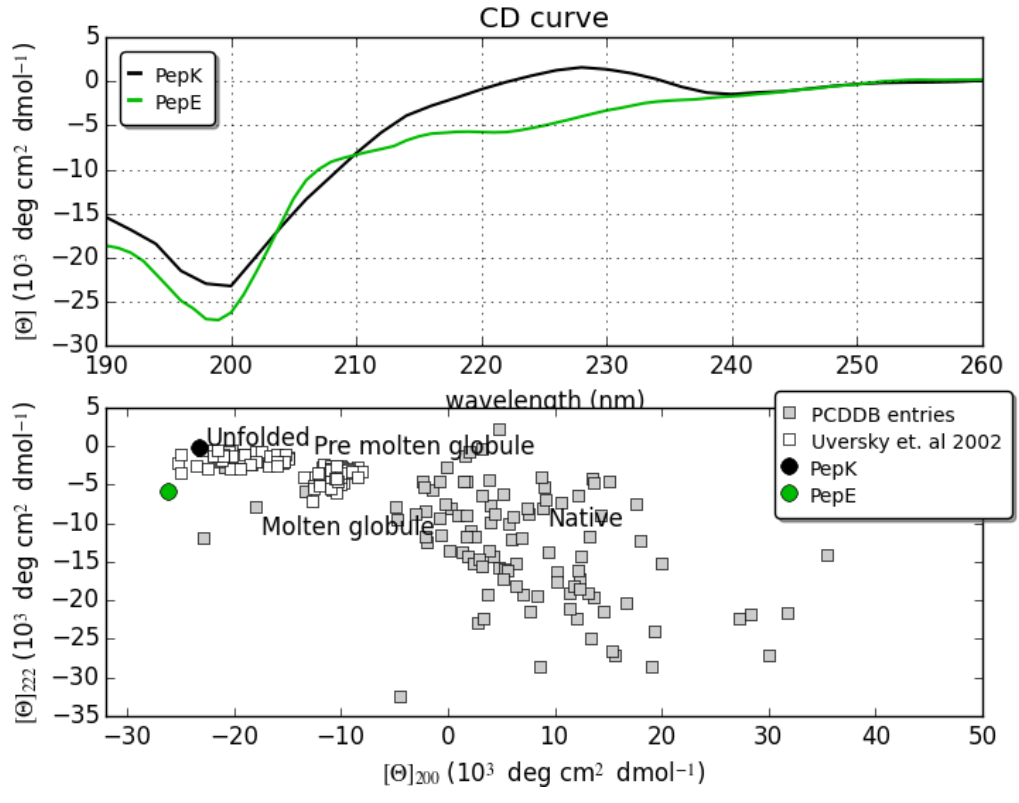
Figure 1. CD spectra of PepK and PepE ( upper panel) and CD analysis by CAPITO tool ( lower panel) where both peptides are indicated as unfolded